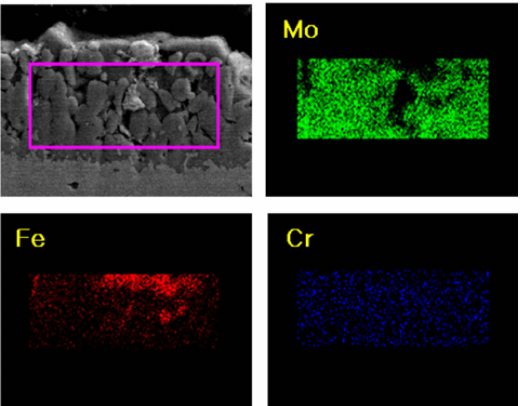
Figure 6. SEM micrograph and EDS mapping of the post-laser-treated TZM alloy that was isothermally heated at 1100 ˝